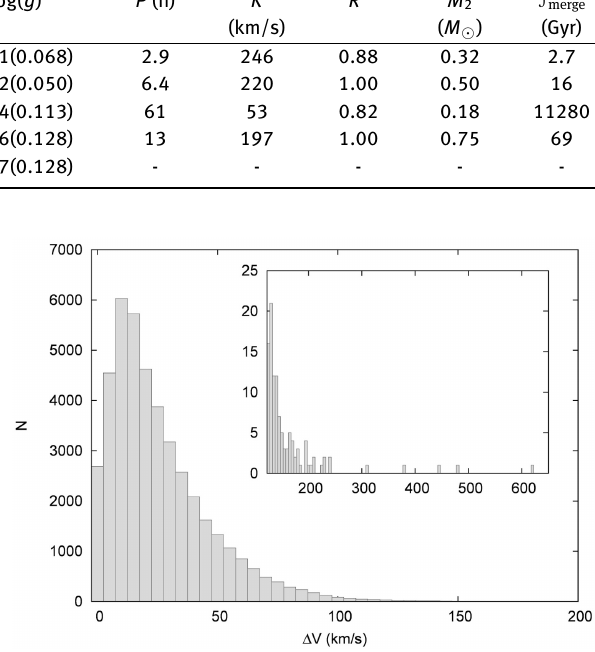
Figure 9. Histogram showing the obtained amplitude for all anal- ysed SDSS spectra. Most show no significant amplitude, but over 300 indicate an amplitude between subspectra larger than 100 km/s, 14 larger than 200 km/s.